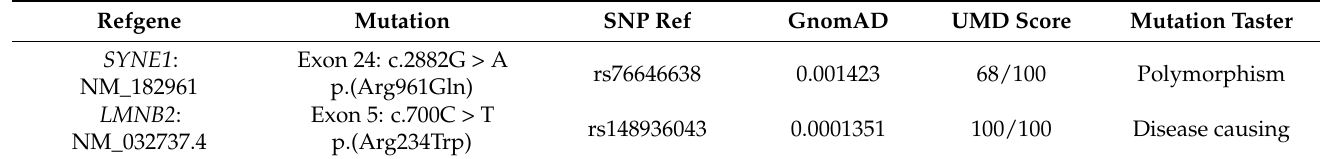
Table 1. Non-synonymous variants found after